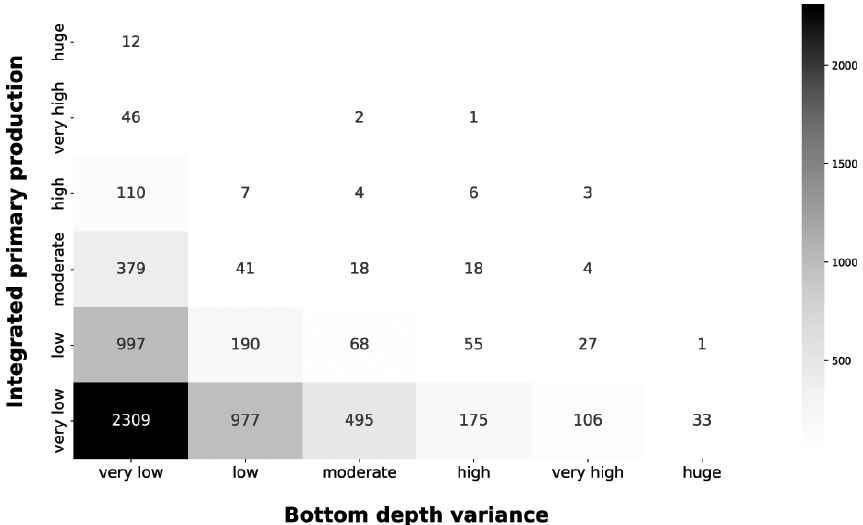
Figure 10. IPP vs. bottom depth variance. The grey heatmap shows the relationship between the variance of the bottom depth and the IPP.